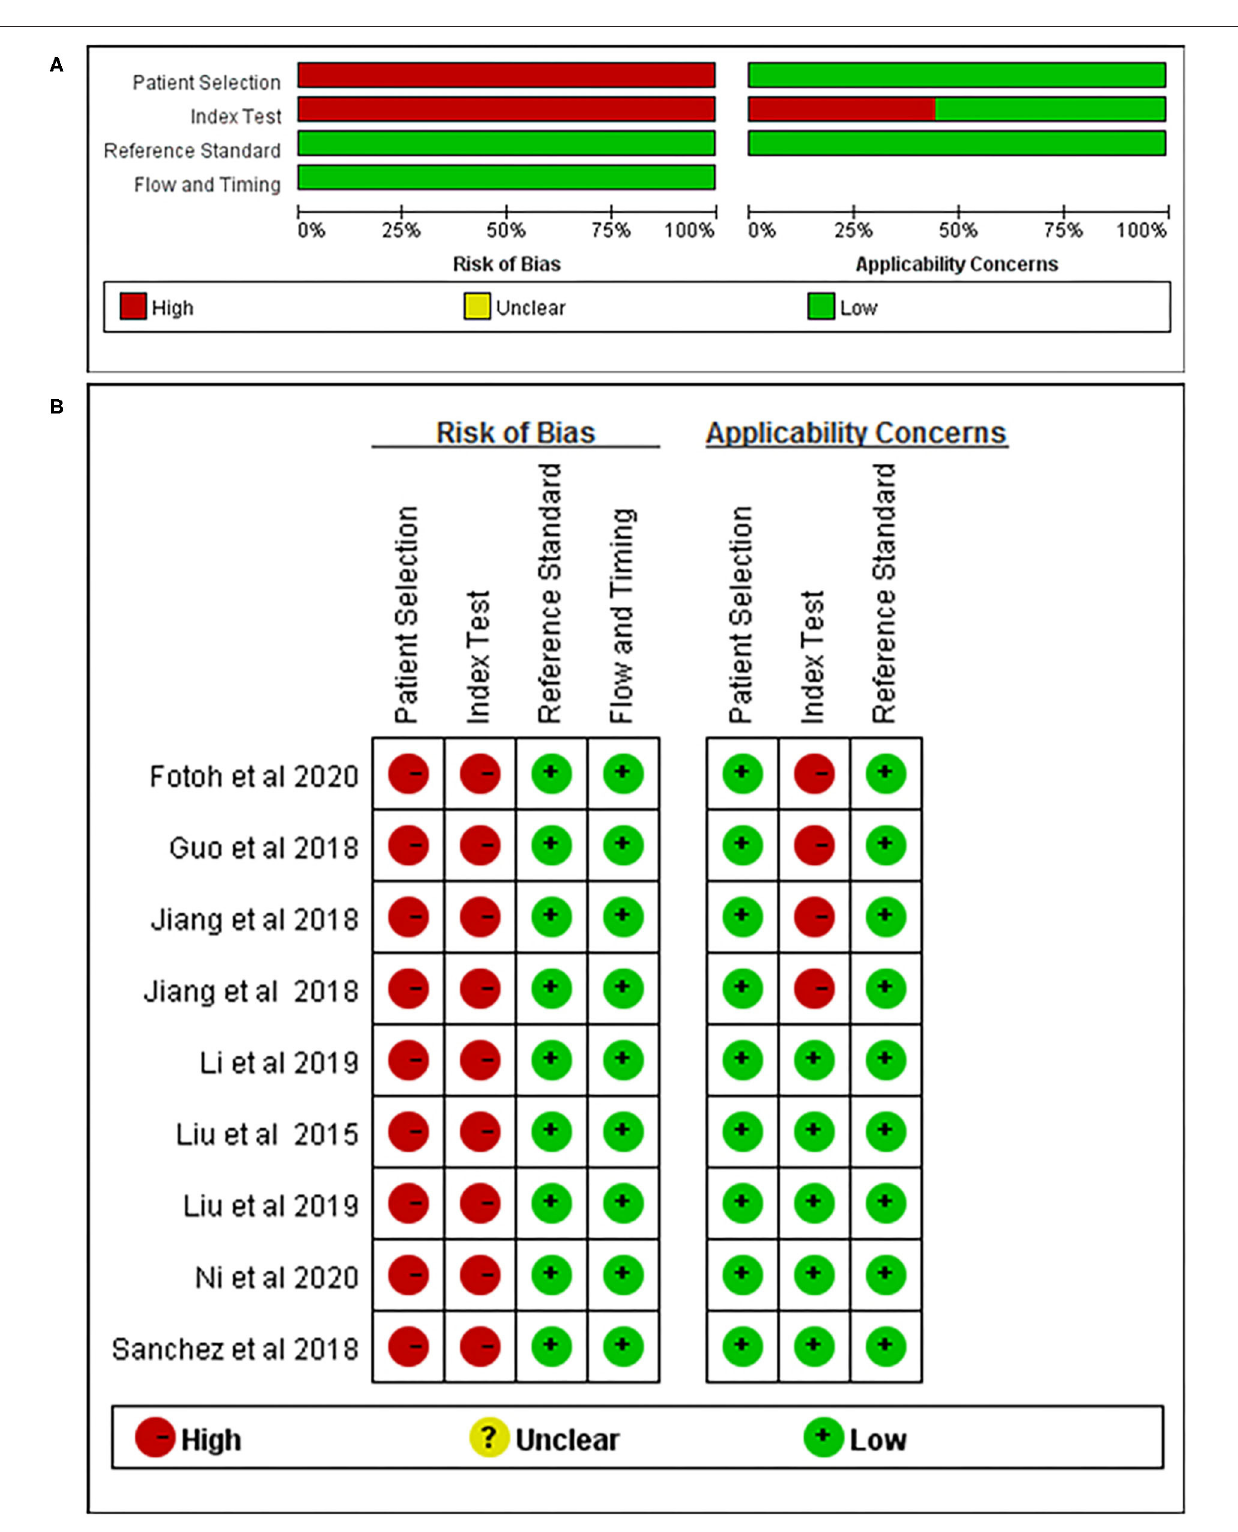
Frontiers in Medicine |